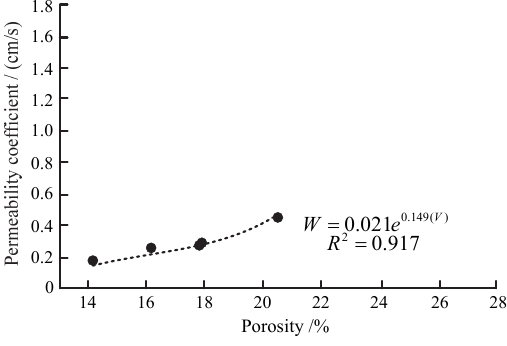
Figure 2: Porosity and permeability